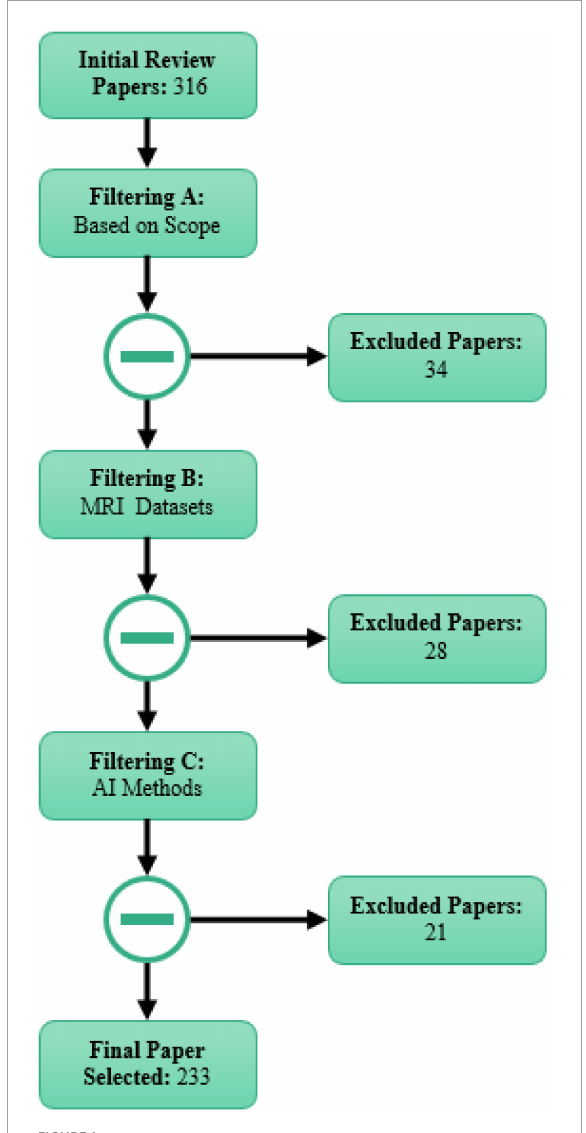
FIGURE1 Papers selection process based on the PRISMA guidelines.